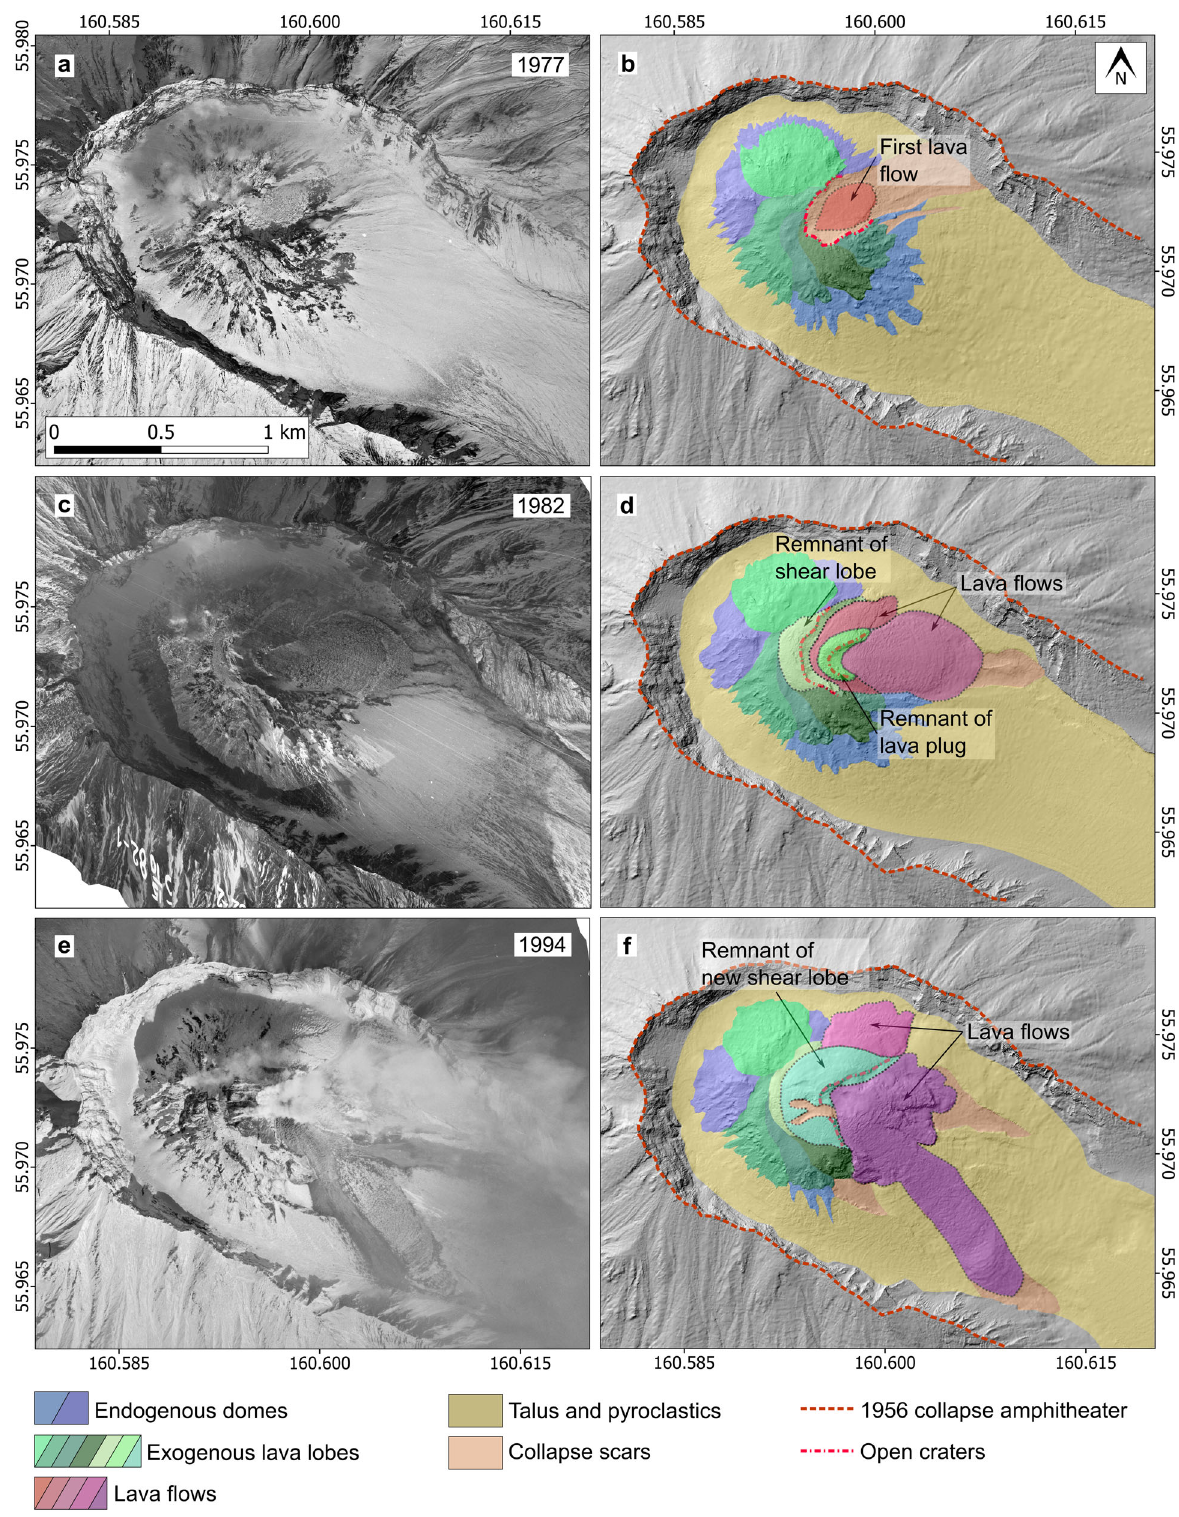
Fig. 4 Exogenous (extrusive – effusive) dome growth in 1977 – 1994. Aerial orthophotos a , c , e and derived hillshade maps b , d , f show remnants of shear lobes and lava plug together with lava fl ows, which poured out from multiple open regrowing edi fi ce resembles the distribution of paths below the lower compressive stress persists between the two lobes of scarp rim, however, the compressive stress beneath the growing maximum horizontal compression (in 0 < x < 0.3 km). Such a “ corridor ” of lower compressive stress may further help magma cone is still lower (as in this simulation the new dome topography rising within the new cone (dark red path in Fig. 7b). This is also did not reach the height of the scarp, yet). In addition, a zone of